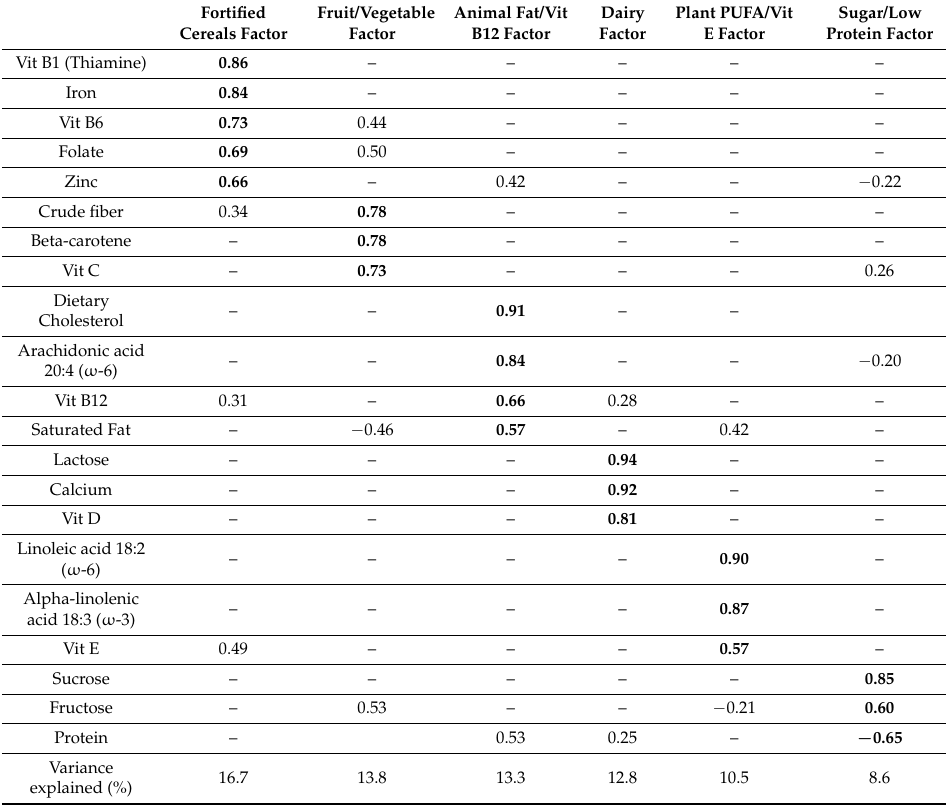
Table 1. Rotated factor pattern from analysis of nutrients derived from the Willet FFQ administered to Rancho Bernardo Study participants ( n = 1499) in 1988–1992.